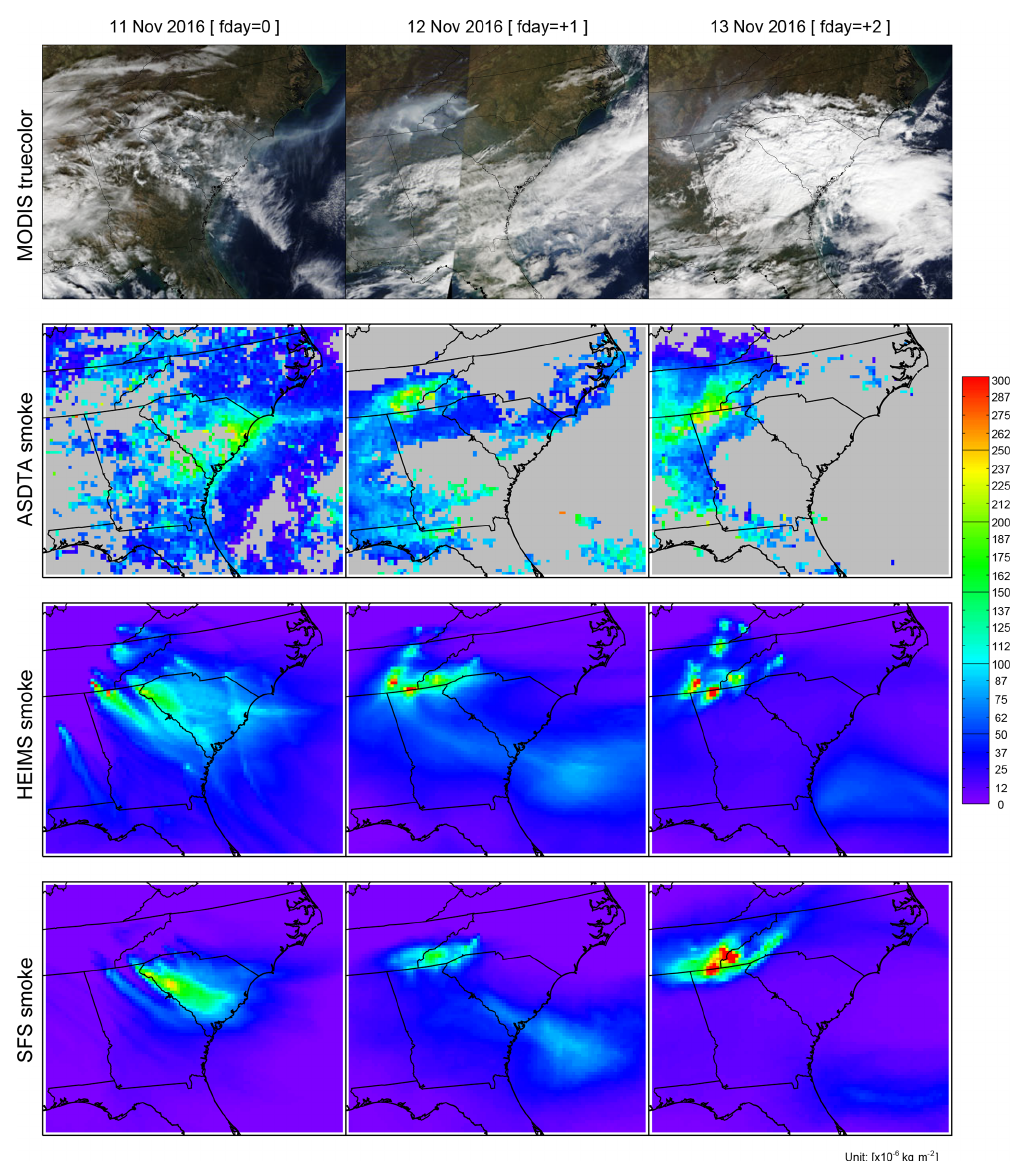
Figure 8. Spatial distributions of observed and forecasted fire smoke plumes on 11–13 November 2016: true-color image from MODIS (top row), ASDTA smoke (second row, converted from AOD), HEIMS smoke hindcast (third row), and SFS smoke forecast (bottom row, from operation) are shown. MODIS true-color images are obtained from https://earthdata.nasa.gov/ (last access: 29 August 2020).